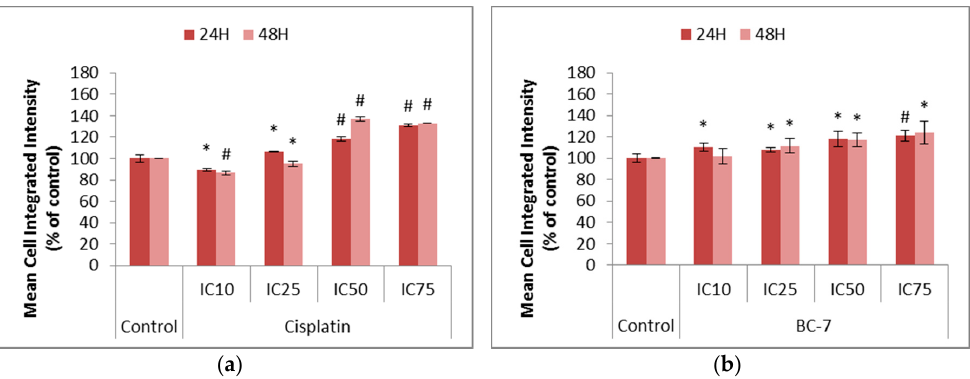
Figure 4. Changes in the levels of Reactive Oxygen Species (ROS) in HeLa cells after 24 and 48 h of treatment with ( a ) cisplatin and ( b ) BC-7. The CellRox ® Orange staining method was used. Control treatment refers to untreated control. Results displayed as mean cell integrated intensity and expressed as a percentage of the untreated control. Error bars indicate SD of three individual experiments, each performed in quadruplicate ( n = 3). Significance was determined using the two-tailed student t -test: * p < 0.05 and # p < 0.005 compared to untreated control.